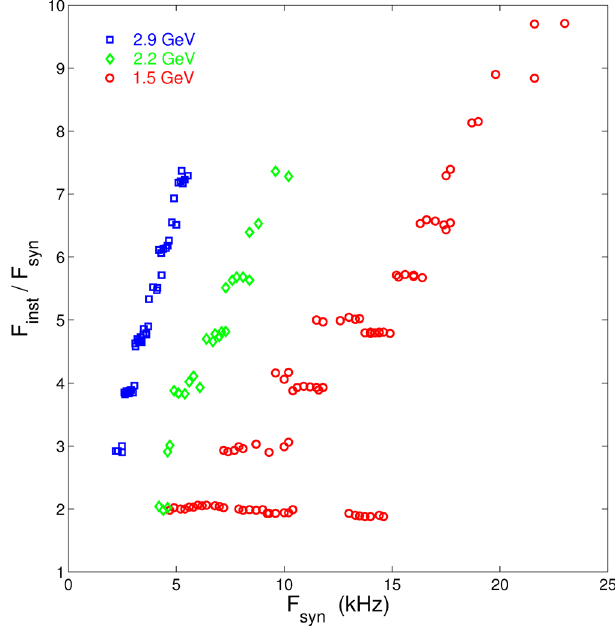
FIG. 6. Instability frequency normalized by the true synchro- tron frequency as a function of the true synchrotron frequency for beam energies 2.9, 2.2 and 1.5 GeV. Excitation of eigenmodes up to m ¼ 11 is evident in the 1.5 GeV data.